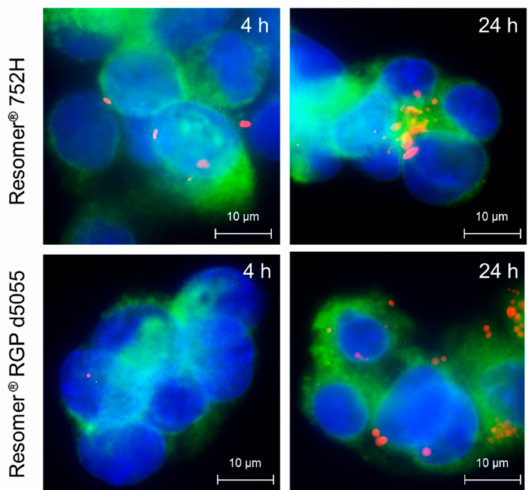
Figure 8. Cellular uptake of either Cy5-conjugated Resomer ® 752H or Resomer ® RGP d5055 nanoparticles (red). Membrane staining was performed by using Alexa488 concanavalin A (green). Nuclei were stained with 4 (cid:48) ,6-diamidino-2-phenylindole